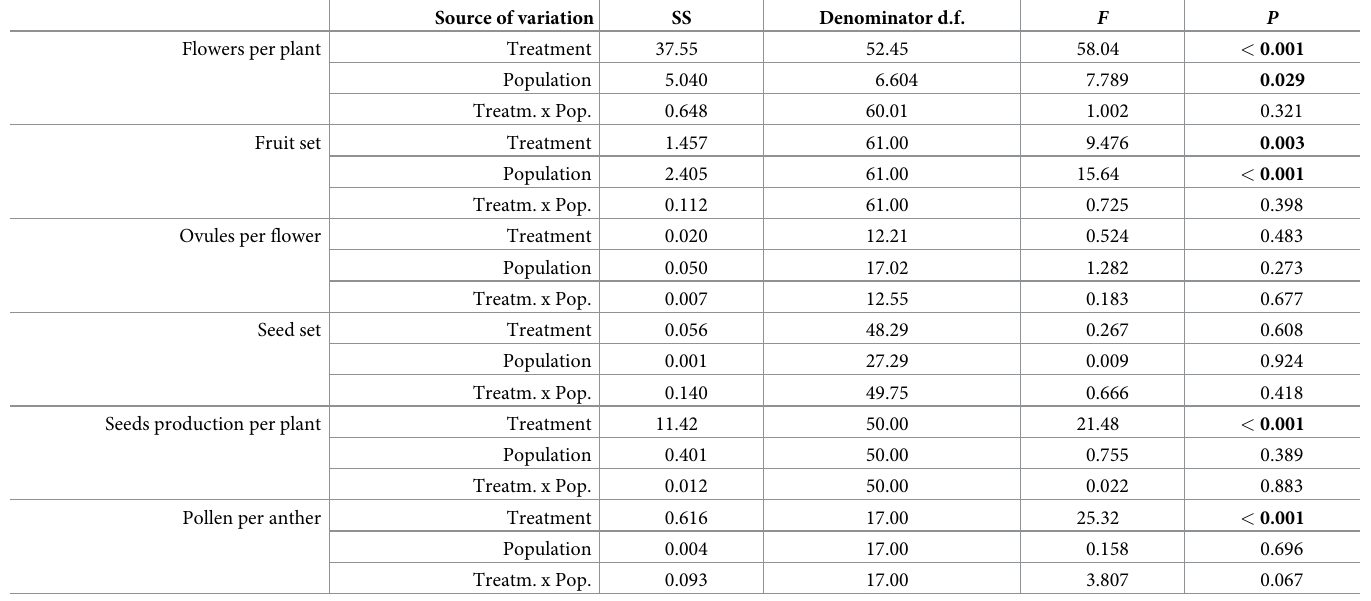
Significant P -values were highlighted in